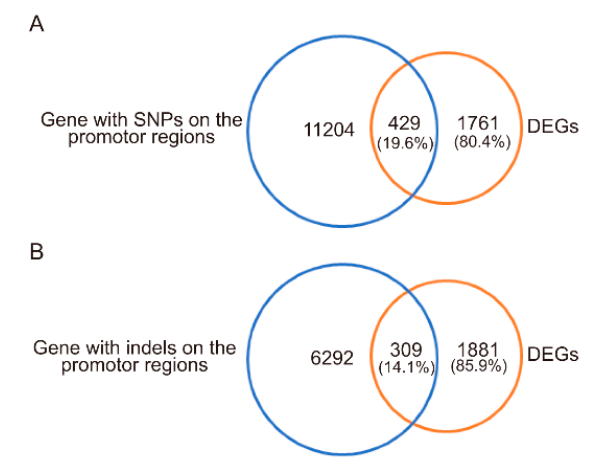
Figure 4. Annotation of homozygous SNPs identified in MU1 based on the comparison with Z12. ( A ) Number and percentile of homozygous SNPs located in genic and intergenic regions. SNPs located in genic regions were further annotated. ( B ) Average frequency distributions of synonymous, nonsynonymous, and large-effect SNPs on each of the 12 rice chromosomes. The X-axis represents frequency distributions, whereas the Y-axis represents the different chromosomes. ( C ) Gene Ontology (GO) enrichment analysis of genes containing nonsynonymous and large-effect SNPs.